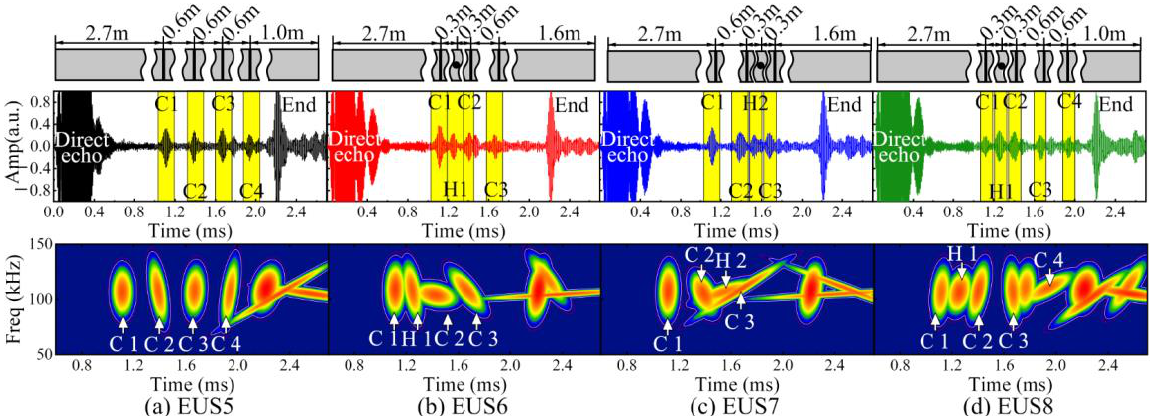
Figure 18. Experimental UGW signals: ( a ) EUS 5, ( b ) EUS 6, ( c ) EUS 7, and ( d ) EUS 8.